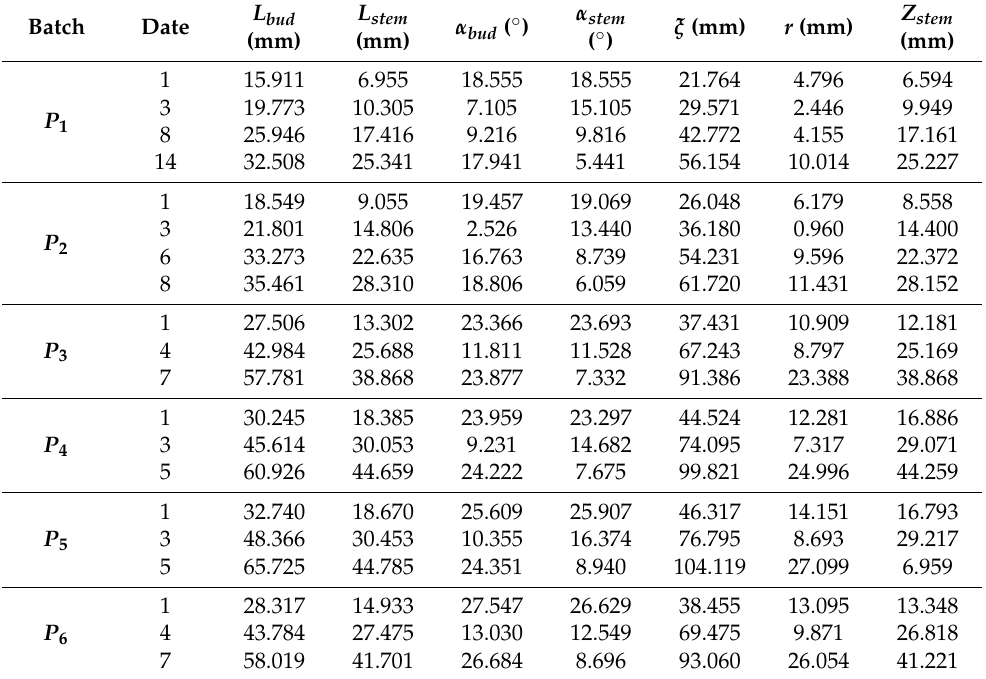
Table 2. Partial experimental